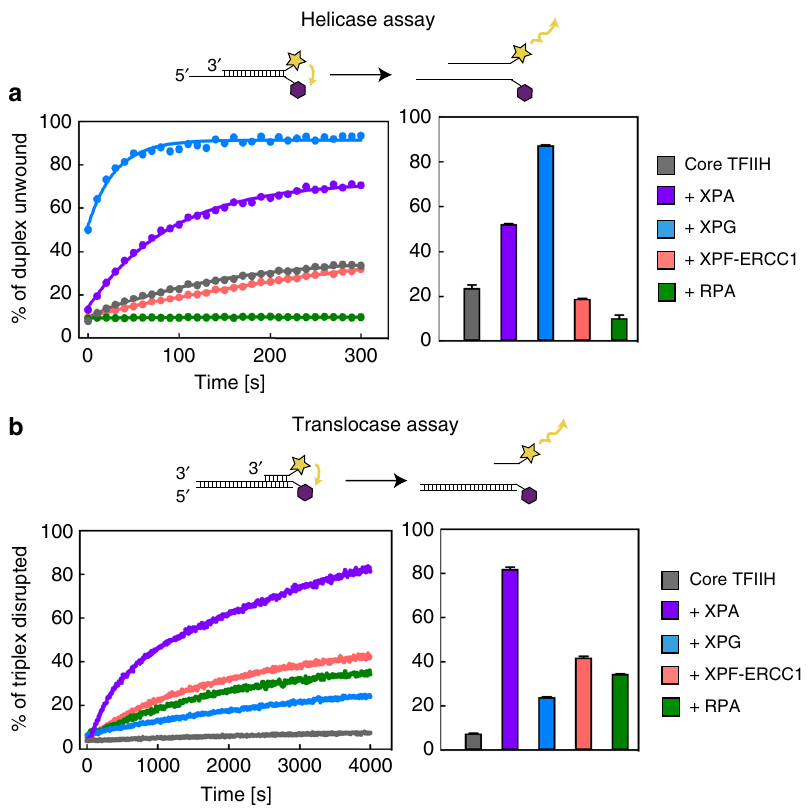
Fig. 1 Regulation of ATPases in core transcription factor IIH. a Effect of nucleotide excision repair (NER) proteins on XPD 5 ′ – 3 ′ helicase activity. Real-time fl uorescence measurement using a fl uorescence energy transfer-based assay. Bars show the percentage of unwound product after 100 s ( n = 2, error bars indicate the range of the data). RPA inhibits XPD helicase activity, by masking the single-stranded DNA overhang. Source Data are provided in the Source Data fi le. b Effect of NER proteins on XPB translocase activity. Real-time fl uorescence measurement of triplex disruption. Bars show percentage of disrupted triplex after 4000 s ( n = 2, error bars indicate the range of the data). Source Data are provided in the Source Data fi le